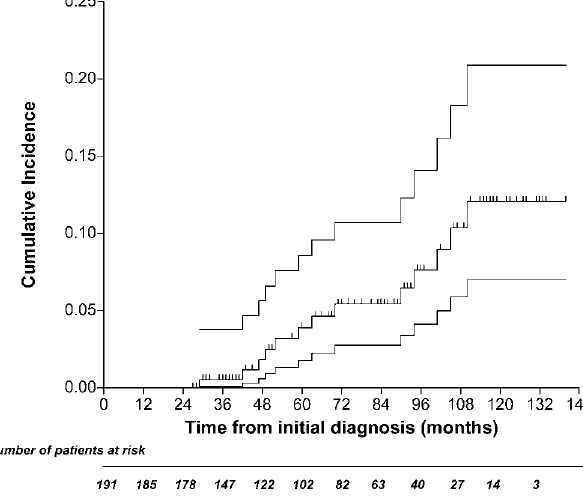
Figure 3. Cumulative Incidence of an Autoimmune Disease Other Than ITP The upper and lower lines indicate the 95% confidence limits. DOI: